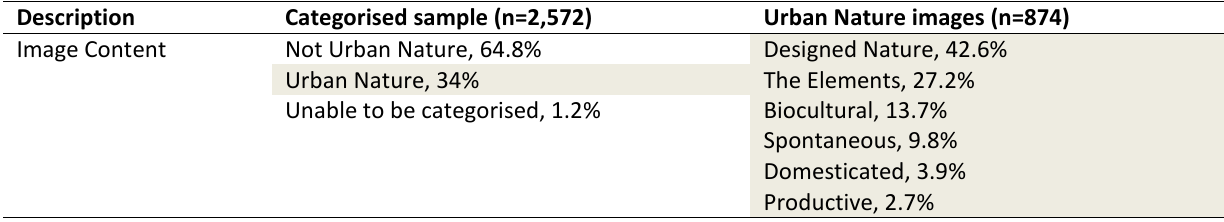
Table 3. Categorisation result of the content